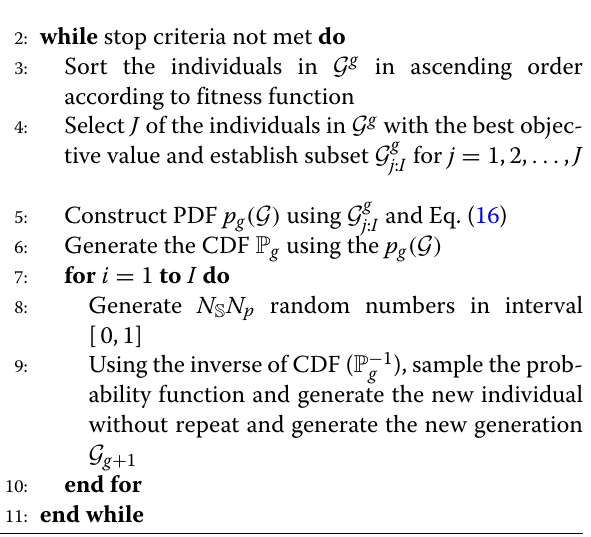
Algorithm 2 Sequential Cross-Entropy-based pilot allo- cation